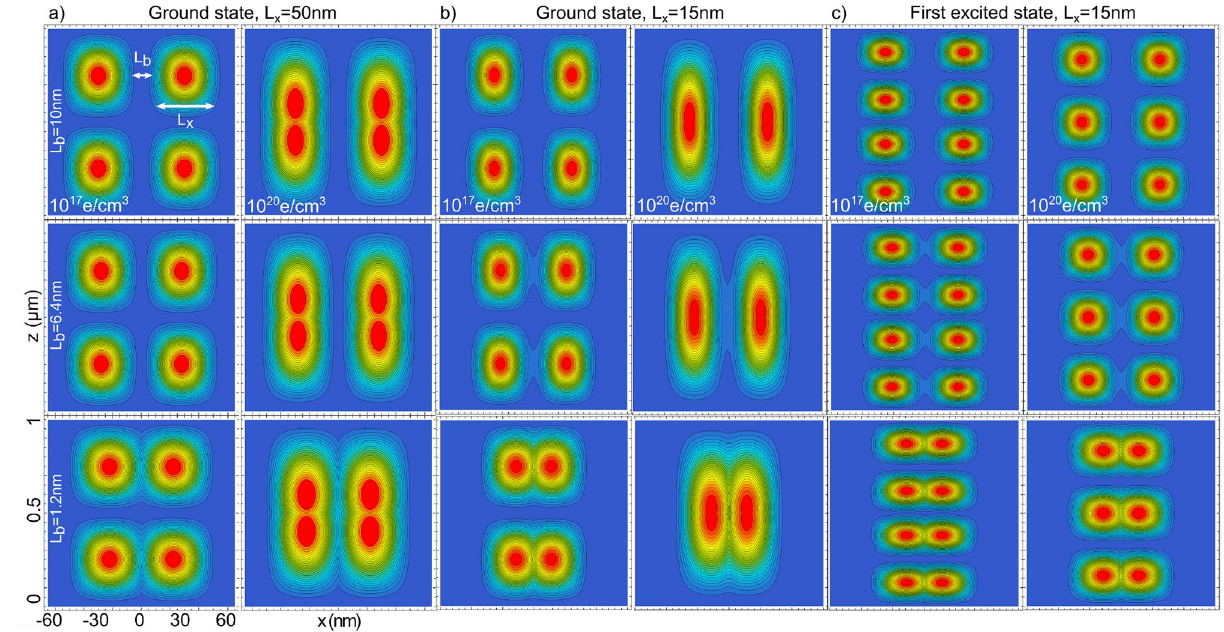
Figure 2. z–x projections of the charge distribution probability for two 1 µ m-long GaAs/AlGaAs PNWs. The plots correspond to: ( a ) ground state for L x , y 15 nm. Two different n -doping concentration are plotted: n state for L x , y = electrons/cm 3 . Each row corresponds to a different L b .